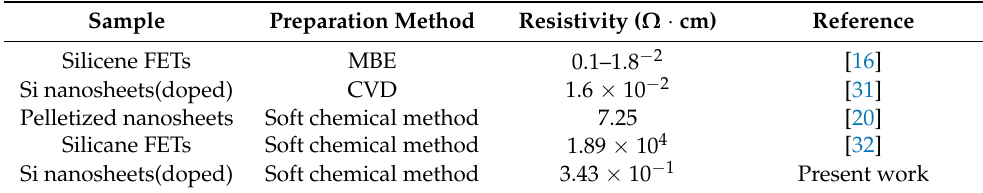
Table 1. Electrical resistivity of silicon nanosheets prepared by different